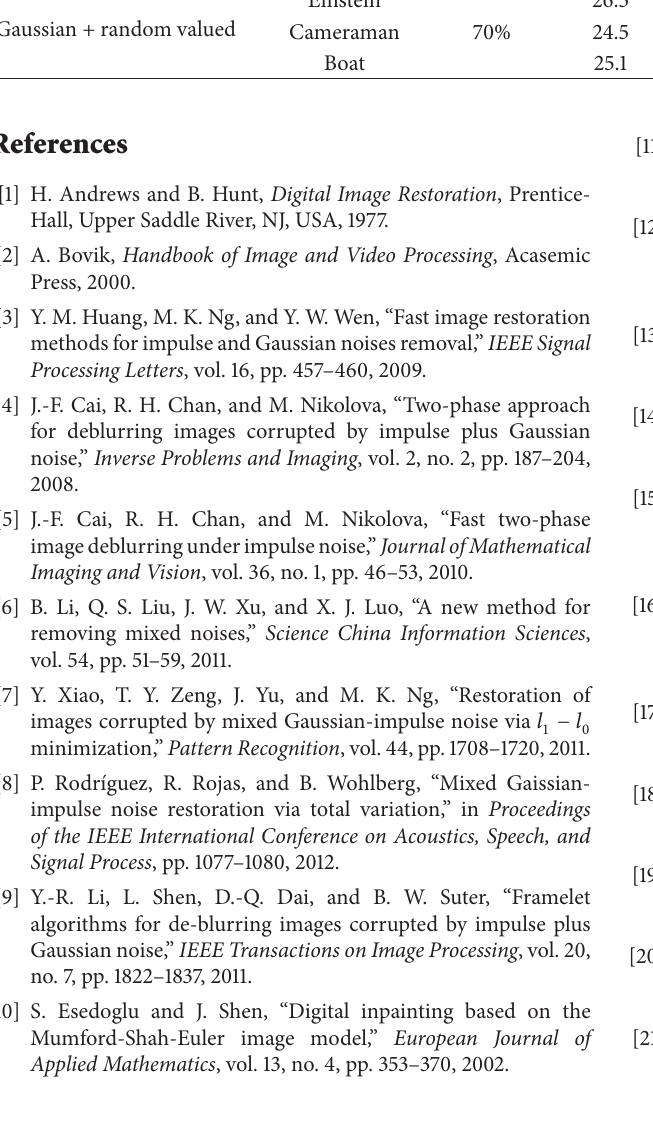
Gaussian + random valued